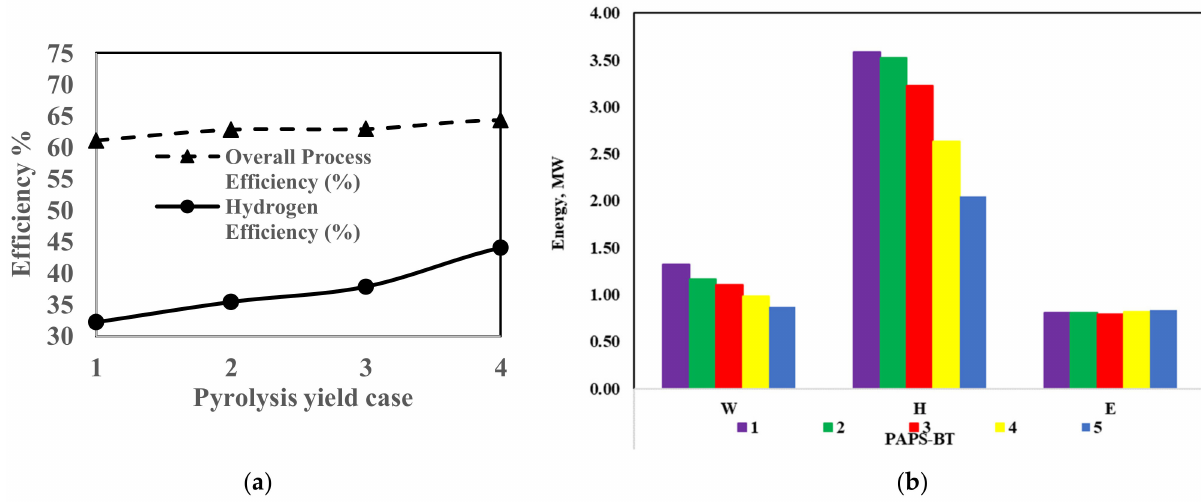
Figure 10. ( a ) Influence of pyrolysis product yield on the overall process efficiency and the hydrogen efficiency. The five cases examined are labelled from 1 to 5 in order of increasing bio-oil yield. ( b ) Turbine work output ‘W’, heat output ‘H’ and electrical input ‘E’ for the various pyrolysis yield cases examined in this